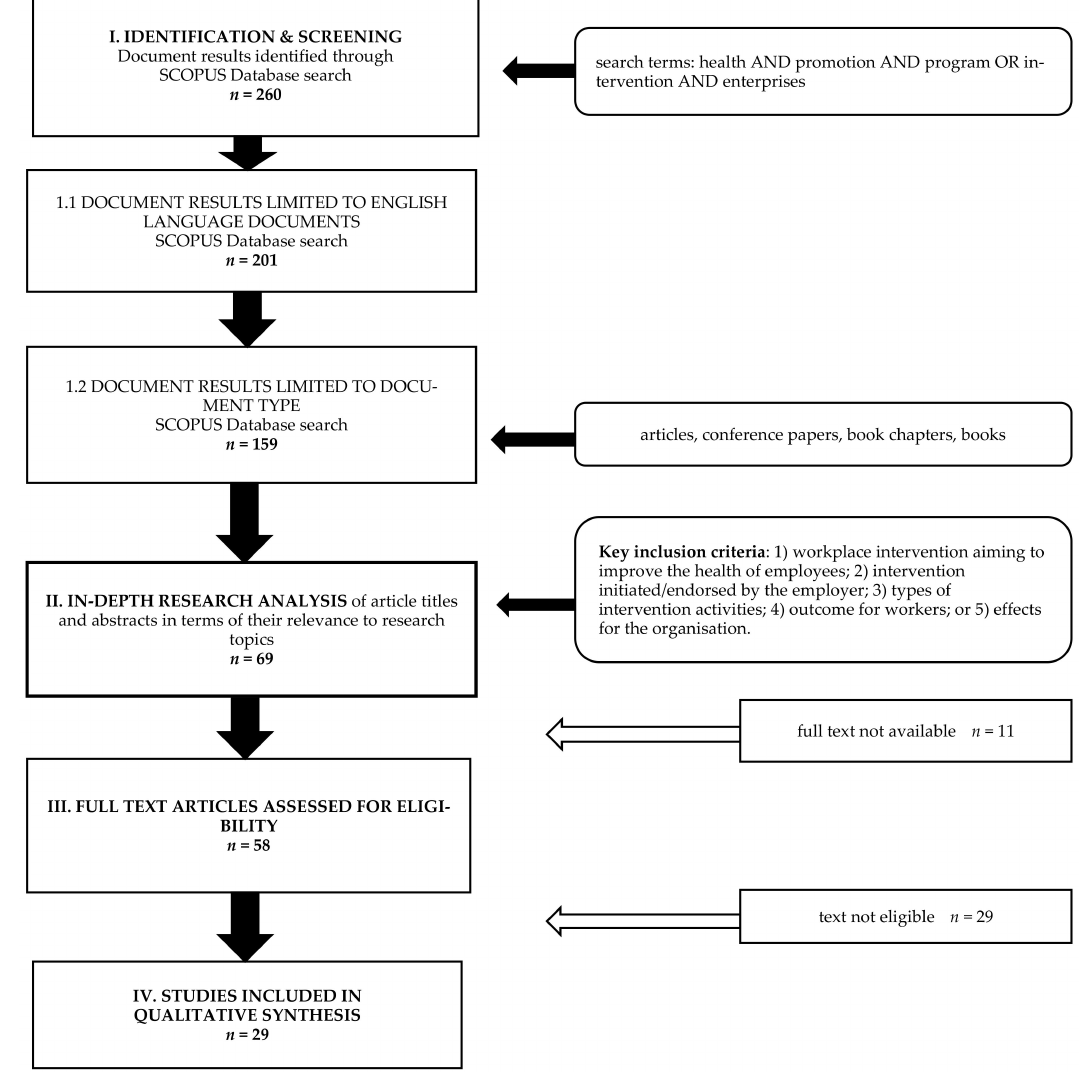
Figure 1. Flow diagram of systematic literature search. Source: Author’s